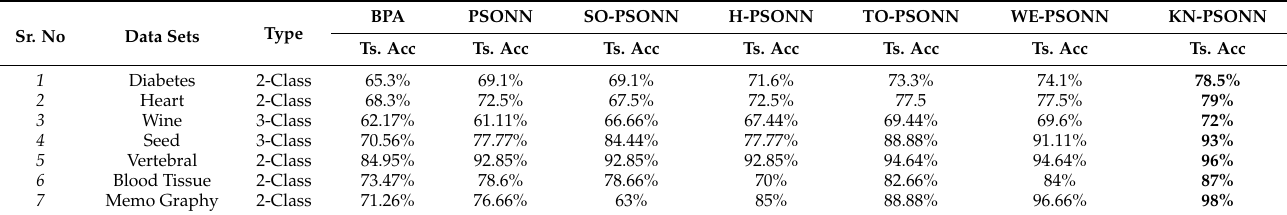
Table 9. Results of 10-fold classification rates of ANN-training methods in for seven data sets for accuracy. Sr. No